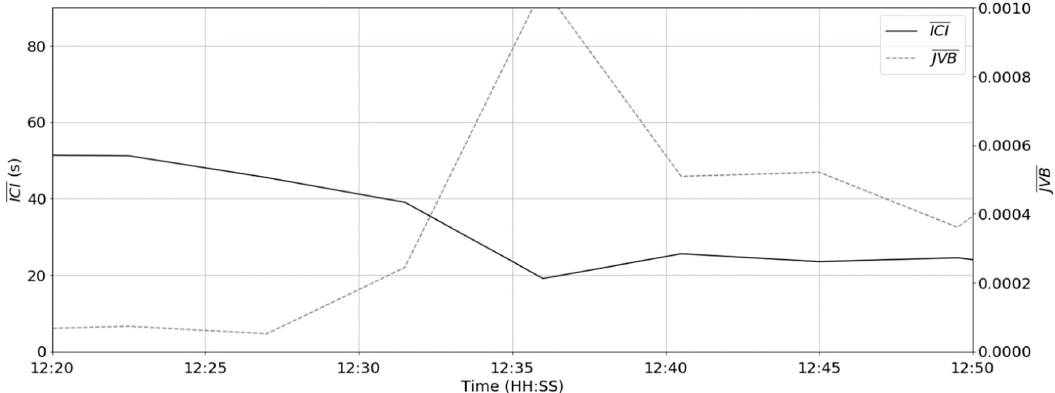
Figure 11. The comparison of the block (270 s) Inter-Contraction Interval (ICI) and JVB over time.